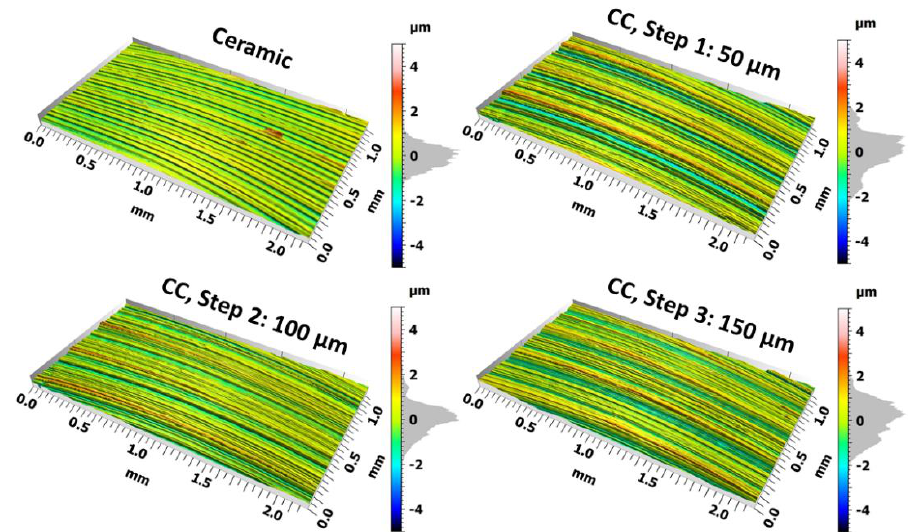
Figure 5. 3D topography illustrations of the first four of the seven milled steps, after ceramic milling (CC), cemented carbide milling after 50 µm, 100 µm and 150 µm. Table 4. Topography results for the ceramic and cemented carbide milled steps after 50 – 350 µm milling.